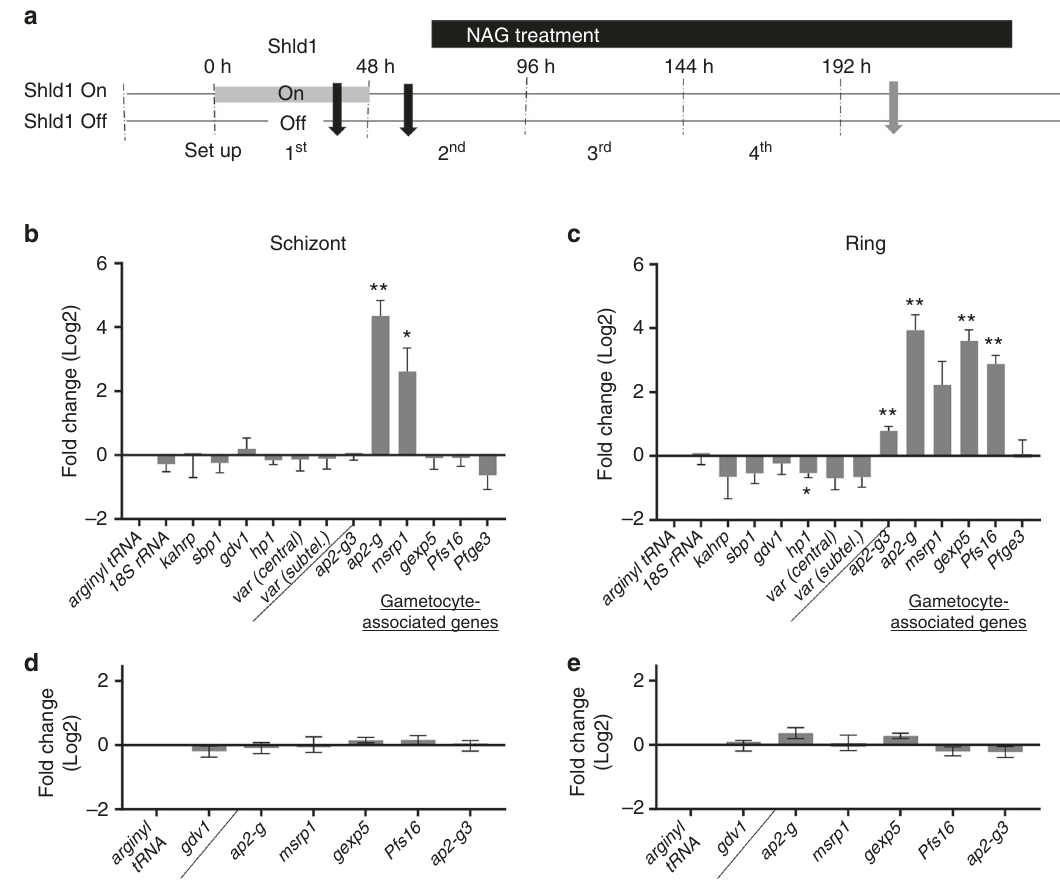
Fig. 7 GDV1-dependent increase in gametocyte-associated genes in Pfgdv1.gfp.dd .T1 parasites. a Schematic of the experiment indicating the Shld1 treatment time. The RNA collection times are indicated by black arrows (38 h Schizonts and 24 h later during the subsequent ring stage) and the grey arrow designates the time the Giemsa-stained smear was made to assess gametocyte production. b – e The fold change in the expression of each gene (2 − ΔΔ C T ) in Pfgdv1.gfp.dd .T1 ( b , c ) or wild type NF54 ( d , e ) parasites at schizont- ( b , d ) or ring- ( c , e ) stages in the presence and absence of Shld1 is shown. The Shld1 minus schizont stage value for each gene is used as a reference and the mean ± s.e.m. of triplicate or quadruplicate fl asks from three independent experiments is plotted. A two-way ANOVA with Sidak ’ s multiple comparisons test followed by a Bonferroni post-hoc test to correct for the analysis of 13 genes was used to determine signi fi cance and probability is indicated, p ≤ 0.05 (*), p ≤ 0.01 (**). The individual 2 − ΔΔ C T for each gene are shown